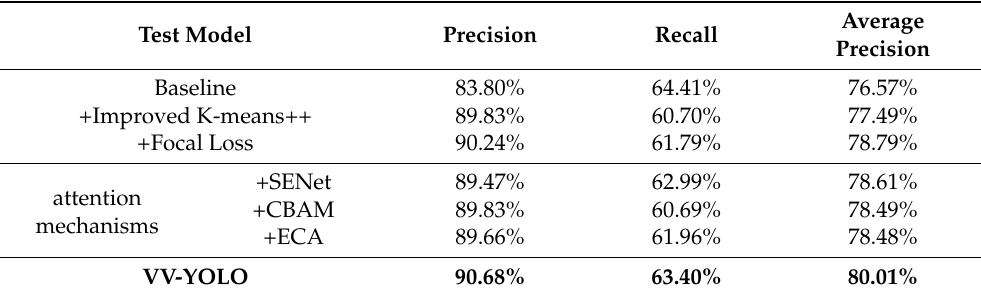
Table 3. Ablation experimental results of VV-YOLO model on the KITTI dataset.